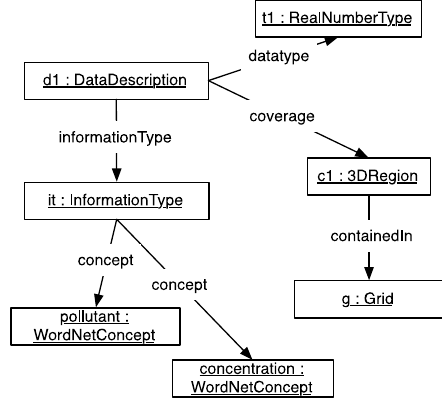
Figure 2. Description of the input data of a